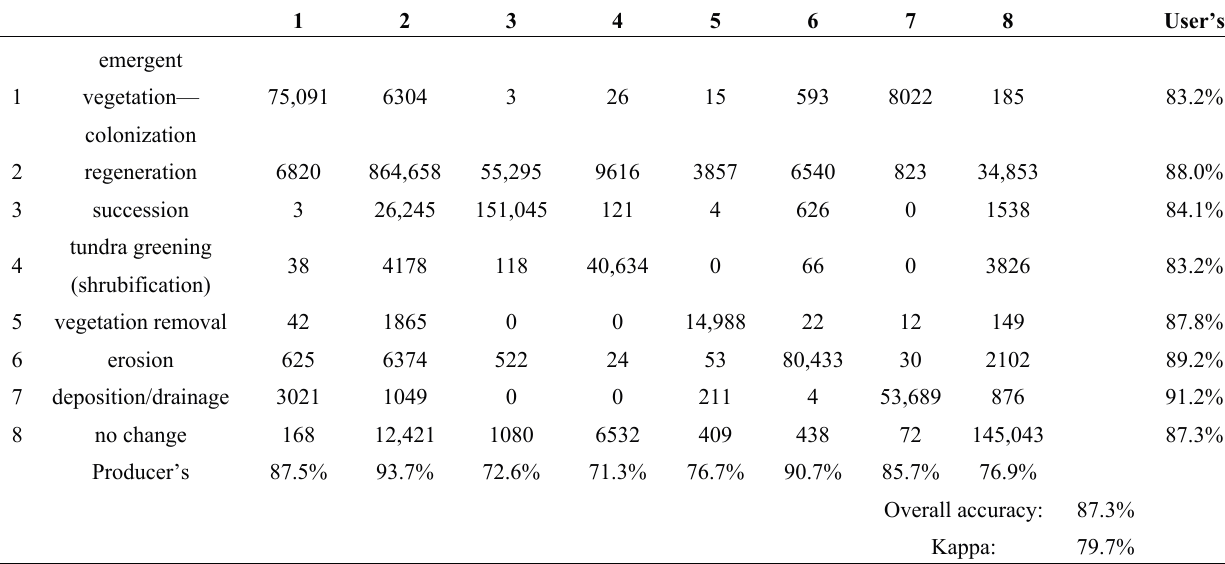
Table 8. Confusion matrix from the decision tree classification of eight underlying change processes using robust linear trend